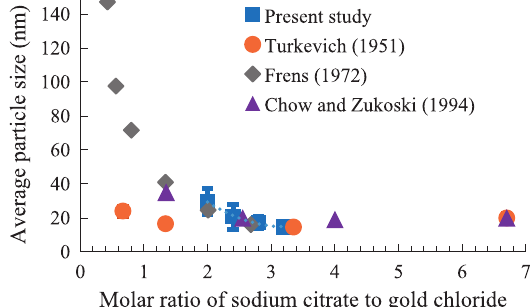
Fig. 6 Control of particle size by changing the molar ratio of NaCt to HAuCl 4 with the Turkevich method.